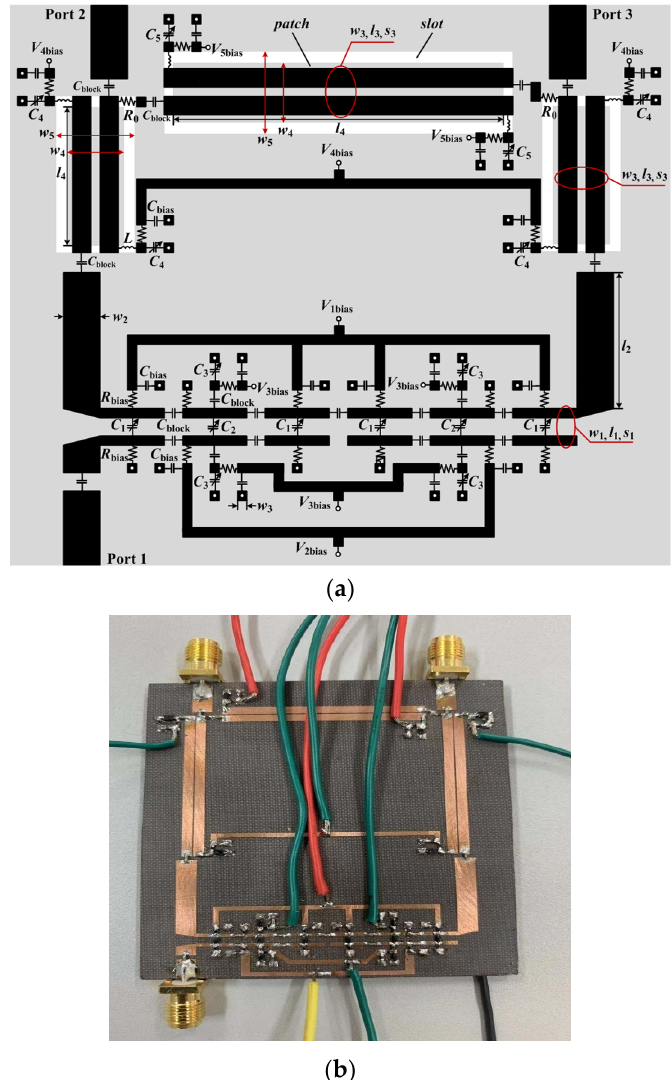
Figure 10. ( a ) Layout and ( b ) photograph of the fabricated prototype. Table 2. Values of components and the main optimized dimensions of the prototype.